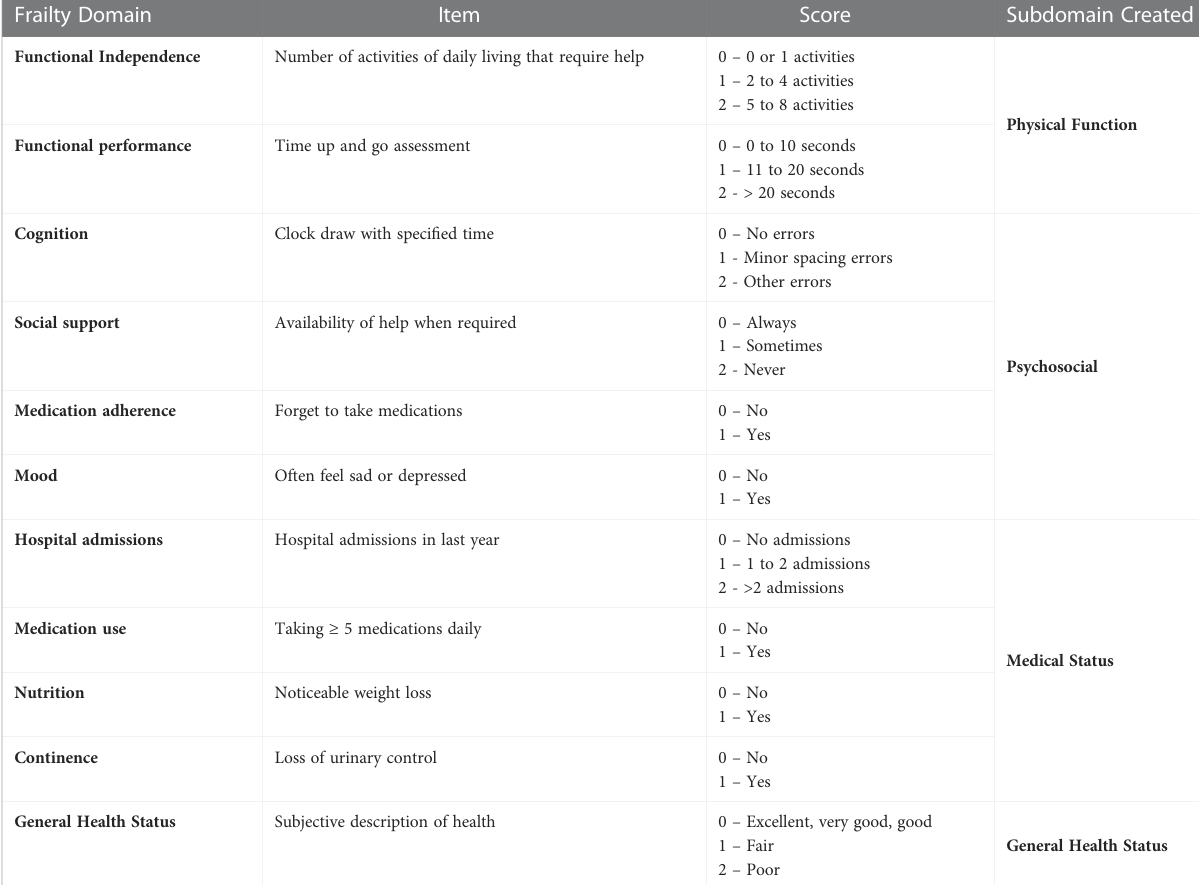
TABLE 1 Summary of the edmonton frail scale. Frailty Domain